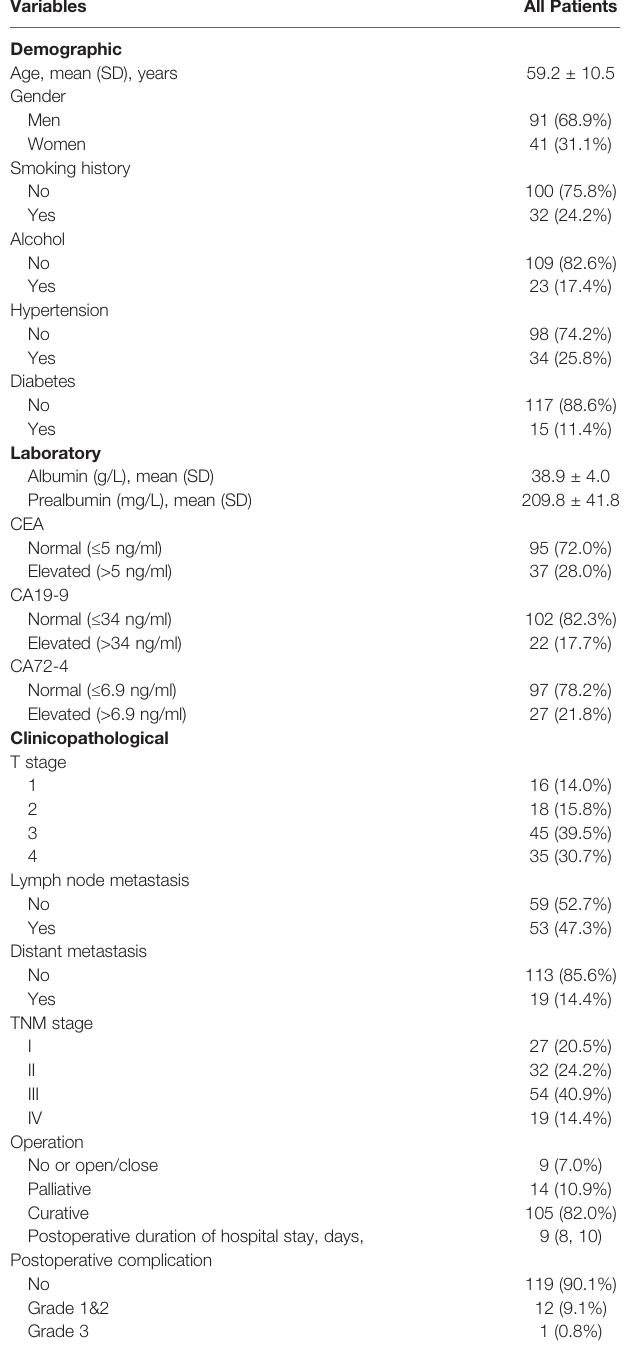
TABLE 1 | The demographic and laboratory characteristics of all patients (n = 132). Variables All